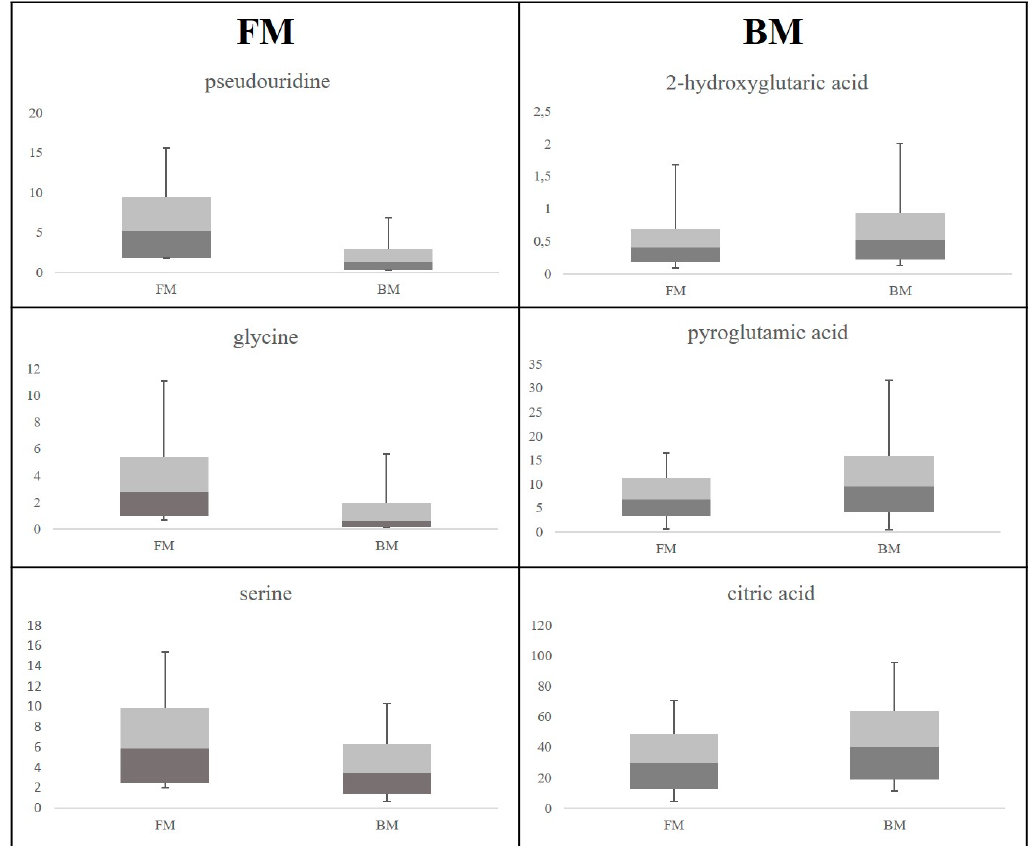
Figure 6. Comparison between most discriminant metabolites. Box plots display the metabolite quantitative variation in each class.